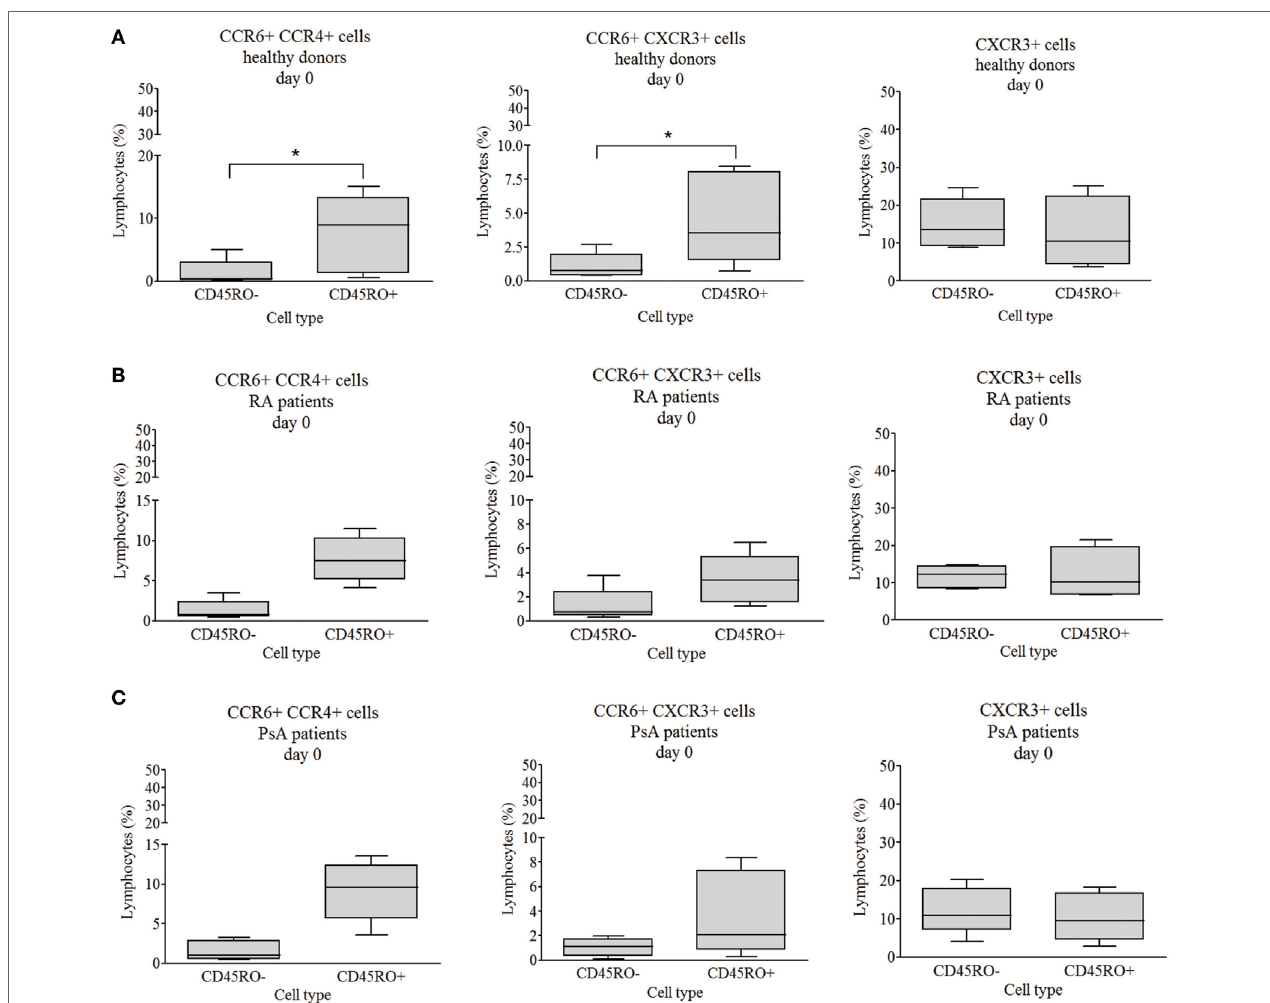
FigUre 3 | CCR6 + CCR4 + , CCR6 + CXCR3 + , and CXCR3 + chemokine receptor expression. The chemokine receptor expression of CD4 + CD45RO − naive and CD4 + CD45RO + memory T cells were studied by flow cytometry. Healthy volunteers’ [ (a) n = 6], rheumatoid arthritis (RA) [ (B) n = 5], and psoriatic arthritis (PsA) patients’ [ (c) n = 5] data. The values are shown in a linear scale; the median, minimum, and maximum values are indicated (Wilcoxon signed rank test * p <